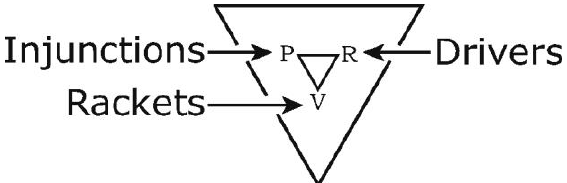
Figure 14: The Four-School Teaching Diagram The Three TA Levels Teaching Diagram Figure 15 focuses on three classic levels of TA